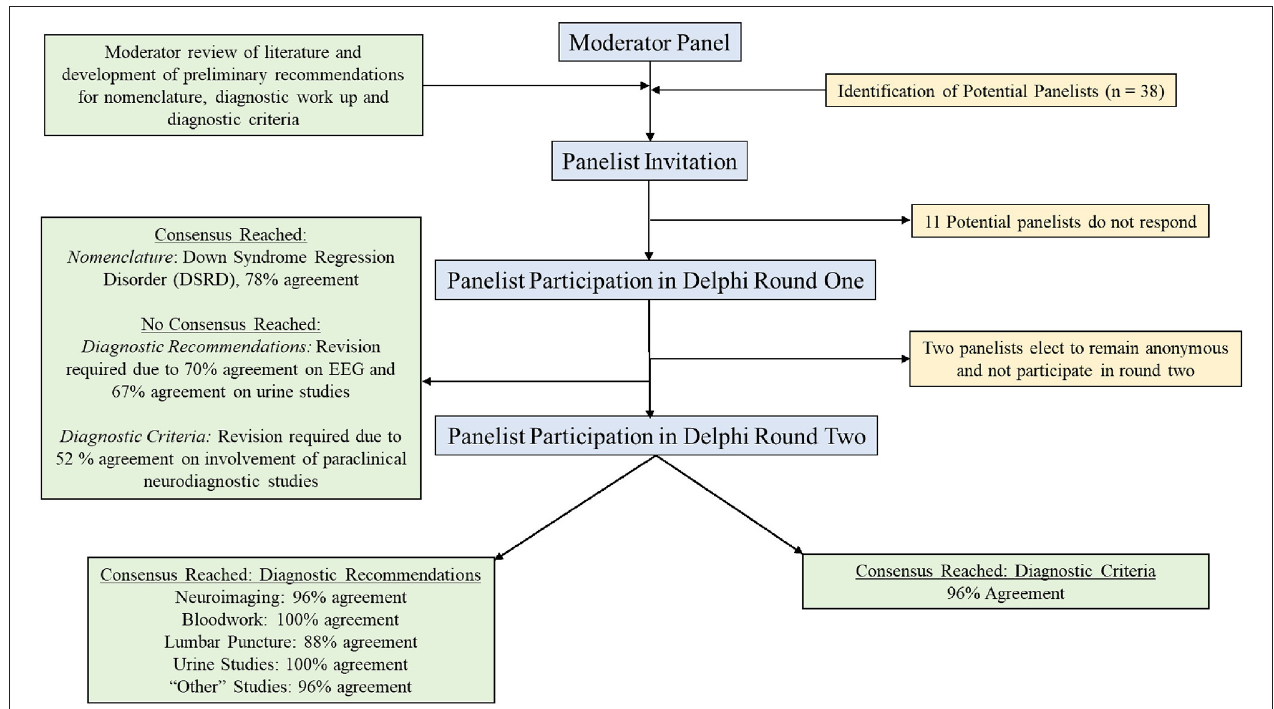
FIGURE 1 | Flow diagram for panelist selection and Delphi method